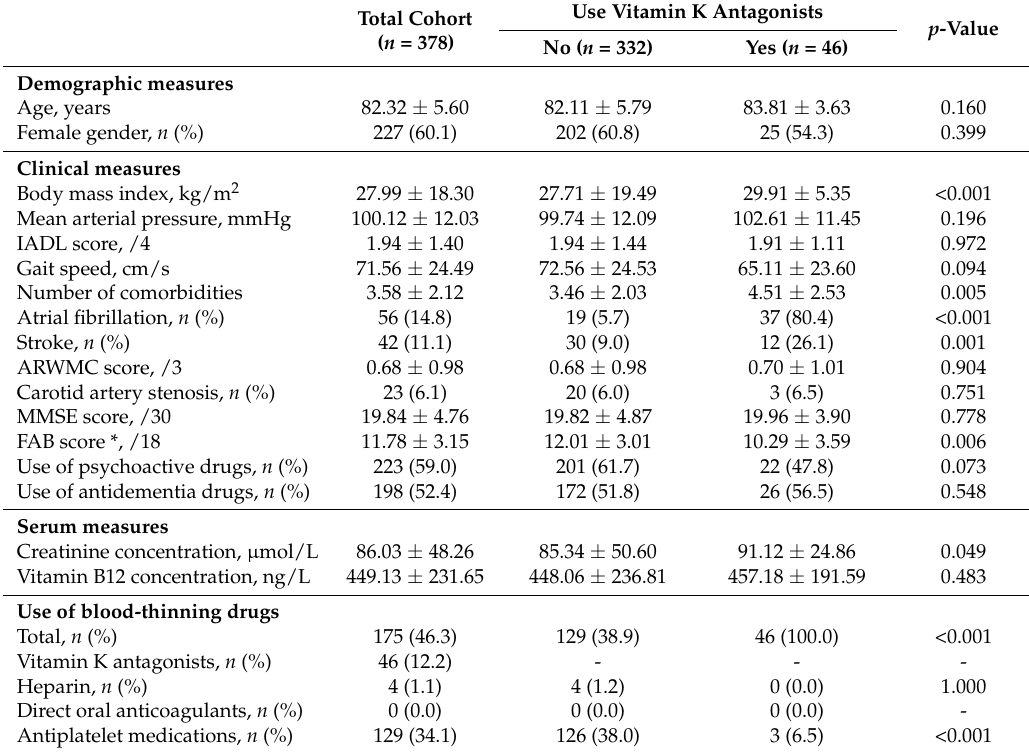
Table 1. Baseline characteristics of 378 participants, according to use of vitamin K